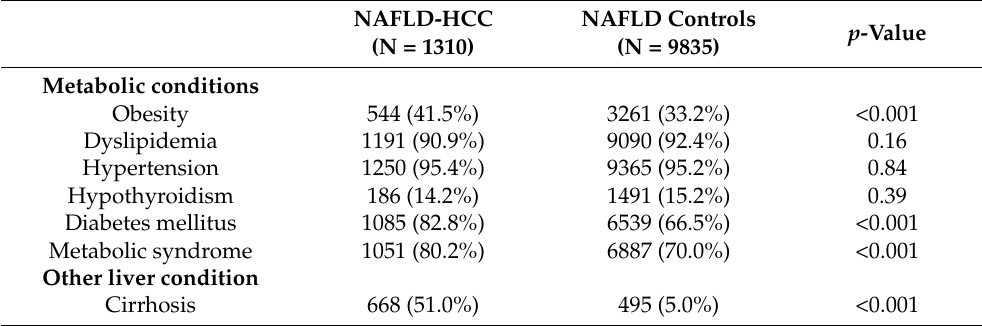
Table 2. Comparison of metabolic risk factors and liver cirrhosis among NAFLD-HCC cases and NAFLD